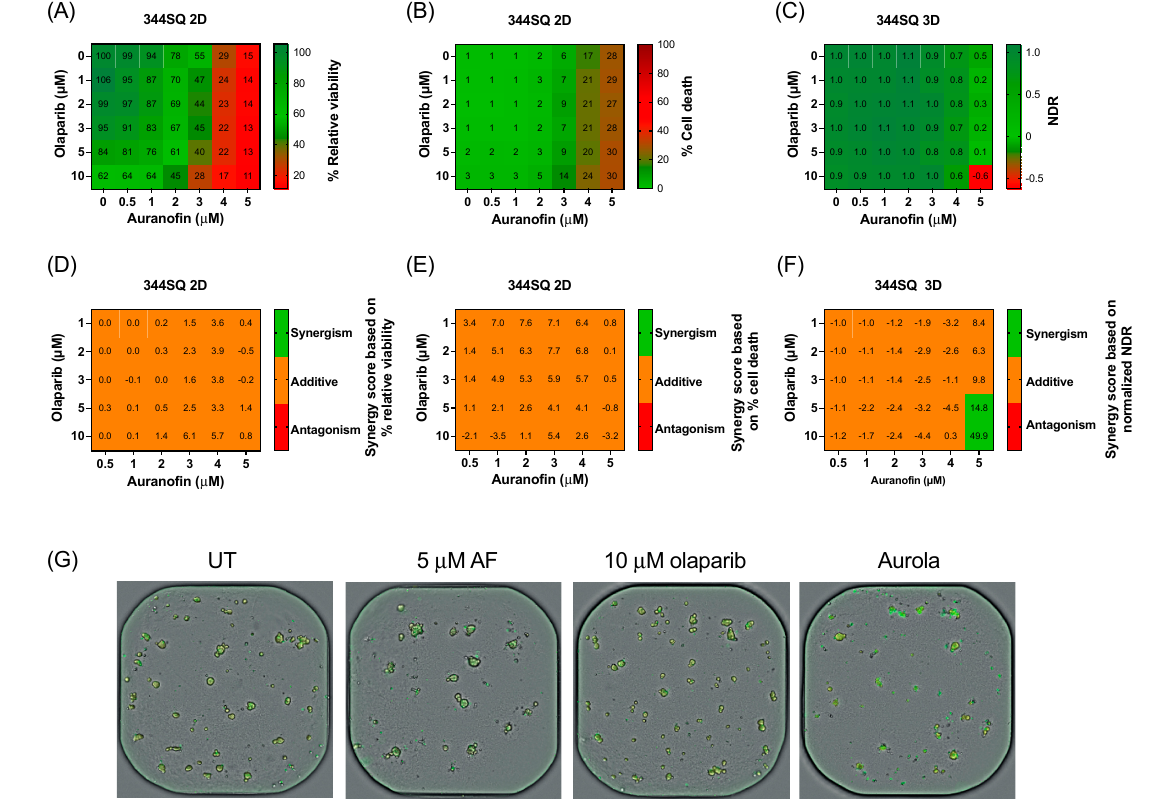
Figure 4. Cytotoxic effect of aurola at more clinically relevant concentrations in the murine 344SQ cells in 2D cultures and 3D spheroids. ( A ) Heatmap representing the relative viability of 2D 344SQ cells after 72 h of treatment with AF (0–5 µ M) and olaparib (0–10 µ M) monotherapy and their combinations. ( B ) Heatmap representing the cytotoxic effect of AF (0–5 µ M) and olaparib (0–10 µ M) monotherapy and their combinations after 72 h in 2D 344SQ cells. ( C ) Heatmap representing the normalized drug response (NDR) of AF (0–5 µ M) and olaparib (0–10 µ M) monotherapy and their combinations after 72 h in 3D 344SQ spheroids. ( D ) Synergy scores for each concentration of AF and olaparib in the targeted titration series after 72 h of treatment in 2D 344SQ cells. Scores were based on drug combination response normalized to percentage viability. ( E ) Synergy scores for each concentration of AF and olaparib in the targeted titration series after 72 h of treatment in 2D 344SQ cells. Scores were based on drug combination response normalized to percentage inhibition (cell death). ( F ) Synergy scores for each concentration of AF and olaparib in the targeted titration series after 72 h of treatment in 3D 344SQ spheroids. Scores were based on drug combination response normalized to NDR. Synergy score >10: synergistic interaction (green). Synergy score − 10 to 10: additive interaction (orange). Synergy score < − 10: antagonistic interaction (red) between two drugs. ( G ) Representative images of 3D 344SQ spheroids treated with corresponding concentrations of AF, olaparib, and their combination using the Spark Cyto imaging system. Yellow signal masks the 344SQ spheroids, while cytotox green signal visualizes dead spheroids. Experiments were performed at least in